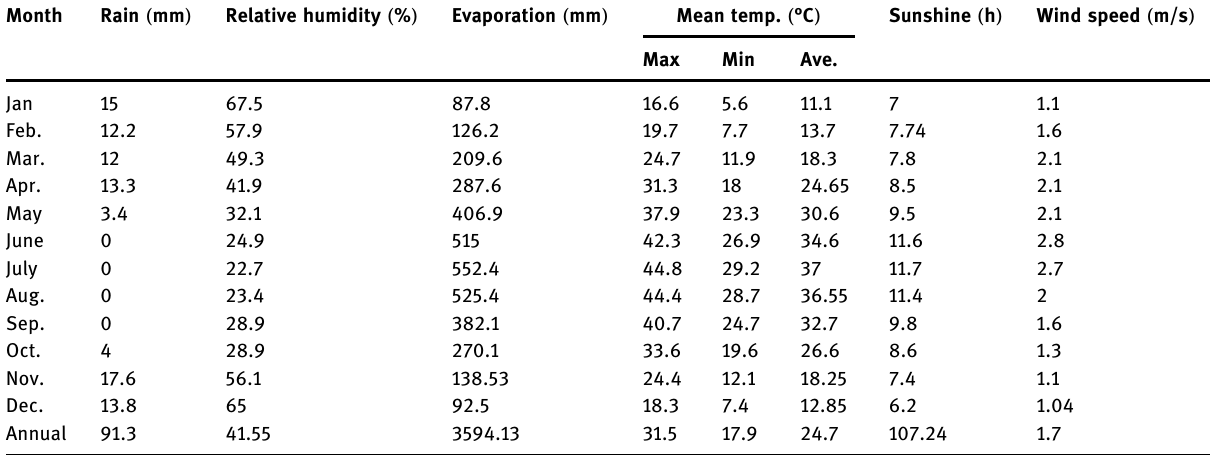
Table 1: Climate data from 1980 to